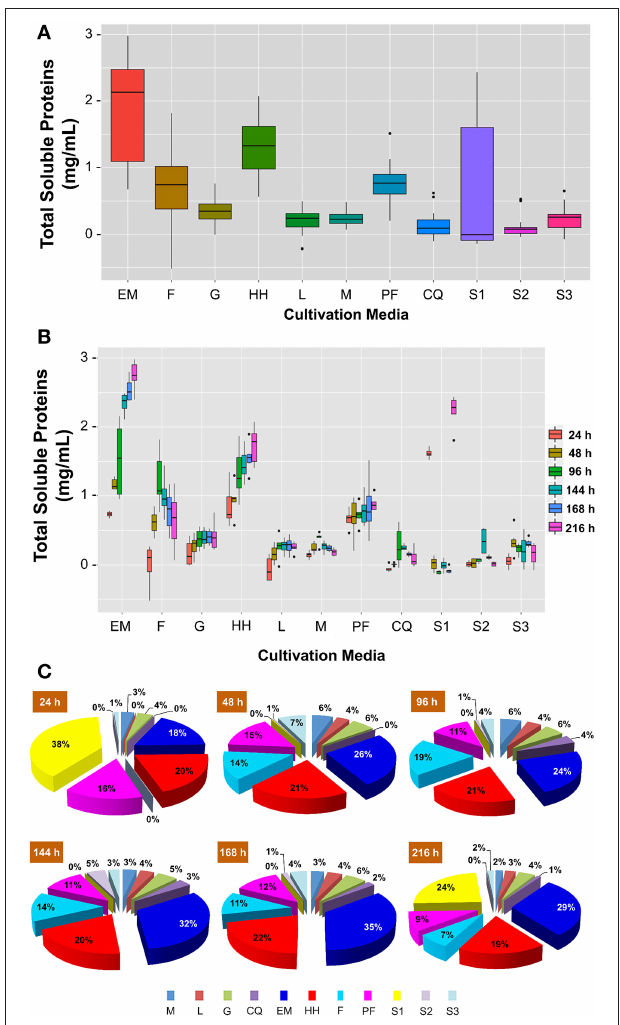
FIGURE 3 | Total soluble proteins exuded by B. bassiana grown in 11 different culture media. (A) Total proteins exuded after 9 days (216h) of cultivation. The boxes display the central tendency and spread for each culture medium. (B) Total soluble protein exuded by B. bassiana through time in 11 culture media. The boxes display the central tendency and spread for each treatment at six different times: 24h (red), 48h (yellow), 96h (green), 144h (turquoise), 168h (blue), and 216h (pink). For (A,B) , the horizontal line inside each box shows the median for each treatment and the dots outside the boxes represent outliers. (C) Total soluble proteins exuded by B. bassiana as a percentage of the total protein exuded at the time of sampling (24, 48, 96, 144, 168, and 216h). The cultures containing EM and HH consistently show the highest protein concentrations through the 9-day experiments. Minimal Medium (M), minimal medium with simple carbon substrate (G, glucose; L, laminarin; CQ, colloidal chitin; S1, S2, and S3, Media with three saponin concentration 0.036, 0.09, and 0.179% w/v, respectively), and minimum medium with complex carbon substrate (EM, E. melanocampta powder; HH, H. hampei powder; F, F. oxyparum powder; PF, P. variabilis powder). p < 0.05, n = 6 independent cultivations.